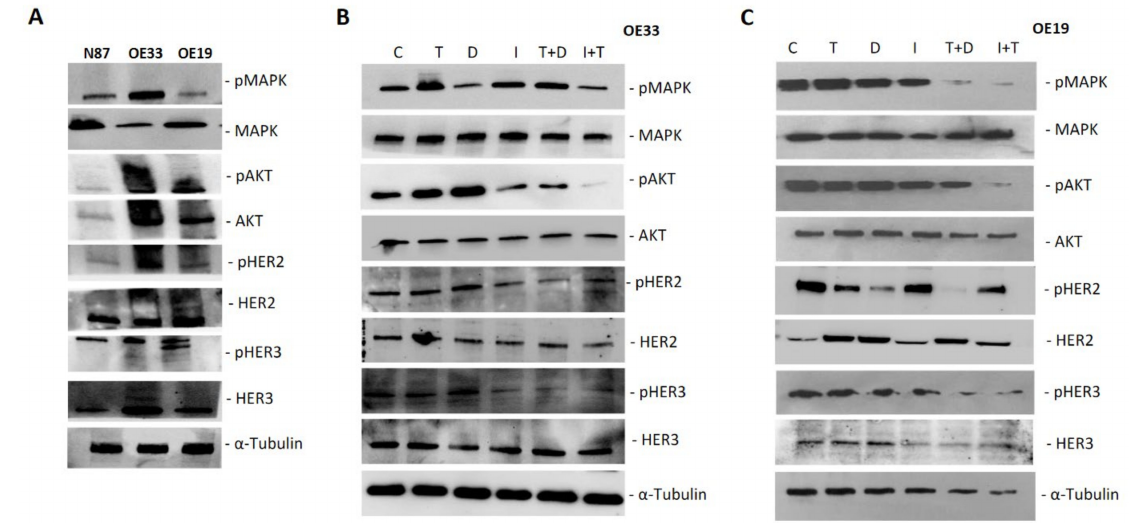
Figure 5. Protein analysis on lysates from N87, OE33 and OE19 cell lines with indicated antibodies ( A ). Western blotting analysis of intracellular proteins and their phosphorylated isoforms following treatment with Trastuzumab, Ipatasertib and Duligotuzmab, as single agent and in combination in OE33 ( B ) and OE19 ( C ). (C: untreated control, T: Trastuzumab, D: Duligotuzumab, I: Ipatasertib, Trastuzumab with Duligotuzumab, T+D; Ipatasertib with Trastuzumab, I+T). α Tubulin was included as a loading control.